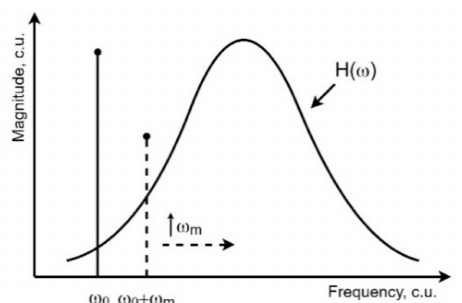
Figure 2. The principle of scanning the frequency response H( ω ) by radiation of an ideal OSSB-signal: ω ω m —modulation frequency (adapted from 0 —frequency of optical carrier;